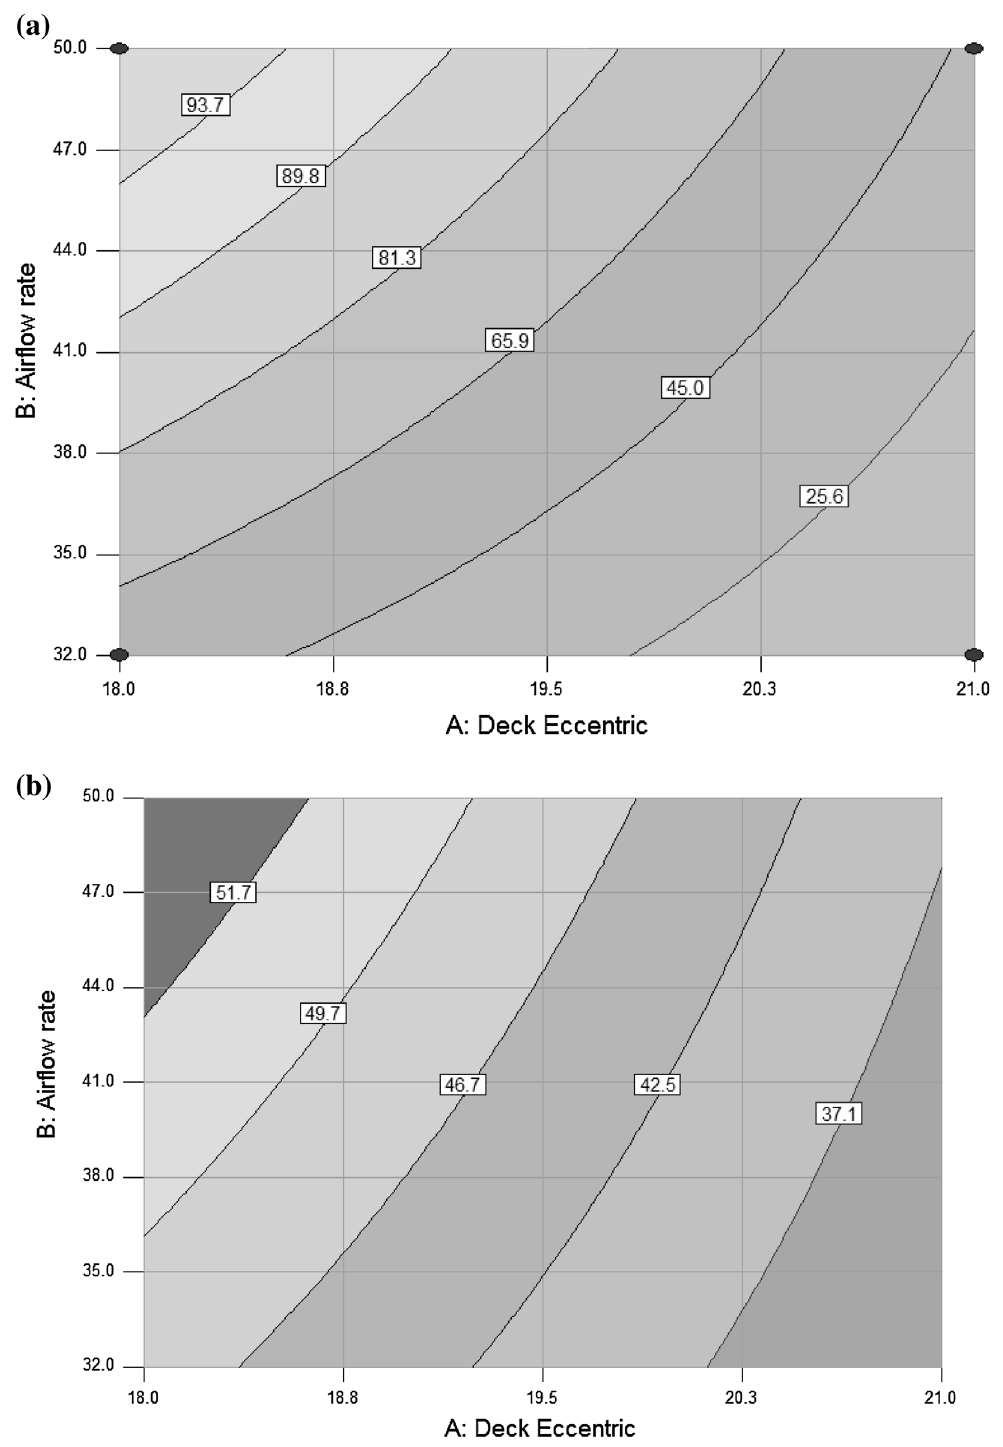
Fig. 8 Interaction effect of deck eccentric and airflow rate at 60 mm Transverse angle: a Yield and b